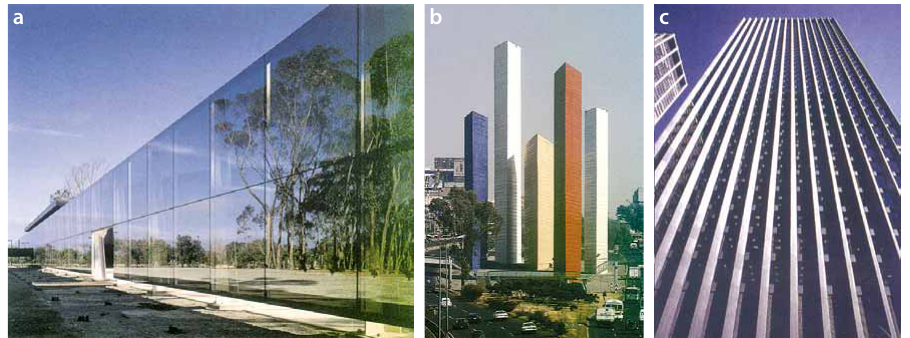
Fig. 7. Mandell Weiss forum in California‘s University (a), San Diego, California. Archit. A. Predock, 1987; Towers in Mexico Cities Suburb (b). Archit. L. Barragan and M. Goeritz, 1957; CBS Building (c),